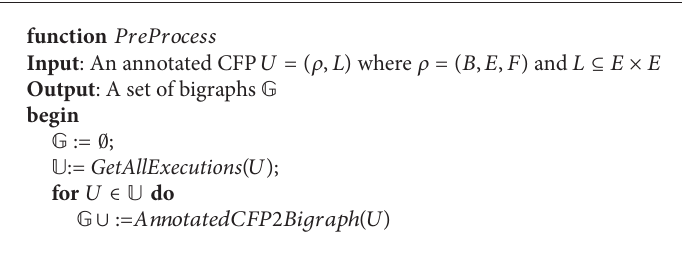
Algorithm 2: Preprocessing an annotated CFP to a set of directed